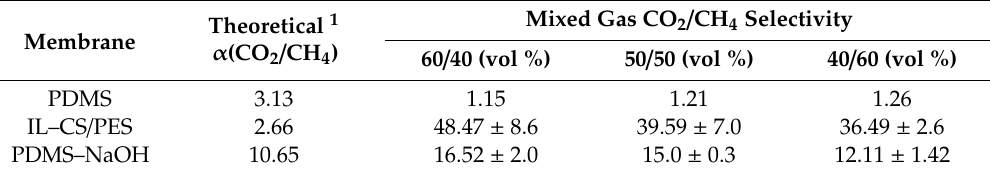
Table 1. Theoretical and mixed gas selectivity results for hydrophobic PDMS and hydrophilic IL–CS / polyethersulfone (PES) membranes.